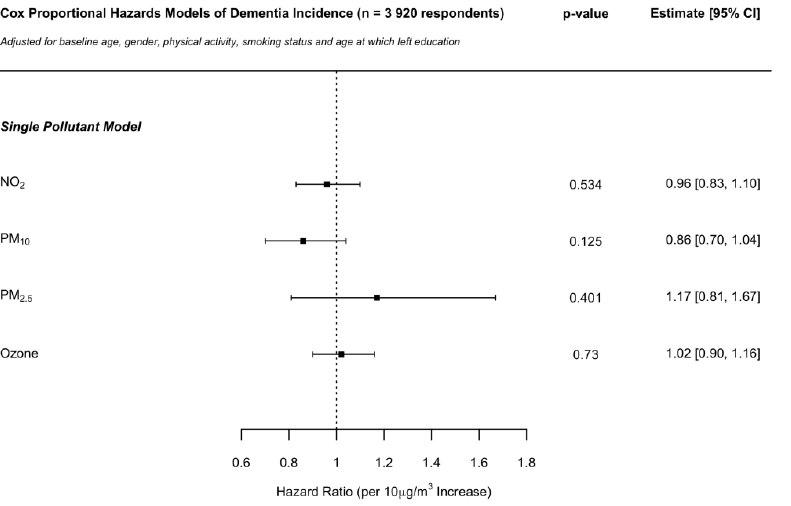
Figure 2. Sensitivity analysis: Cox proportional hazards model hazard ratios per 10 μg/m 3 increase in NO 2 , PM 10 , PM 2.5 and ozone concentrations on dementia incidence in the ELSA cohort across England. Independent single pollutant models adjusted for baseline age, gender, physical activity, smoking status, and age at which left education.